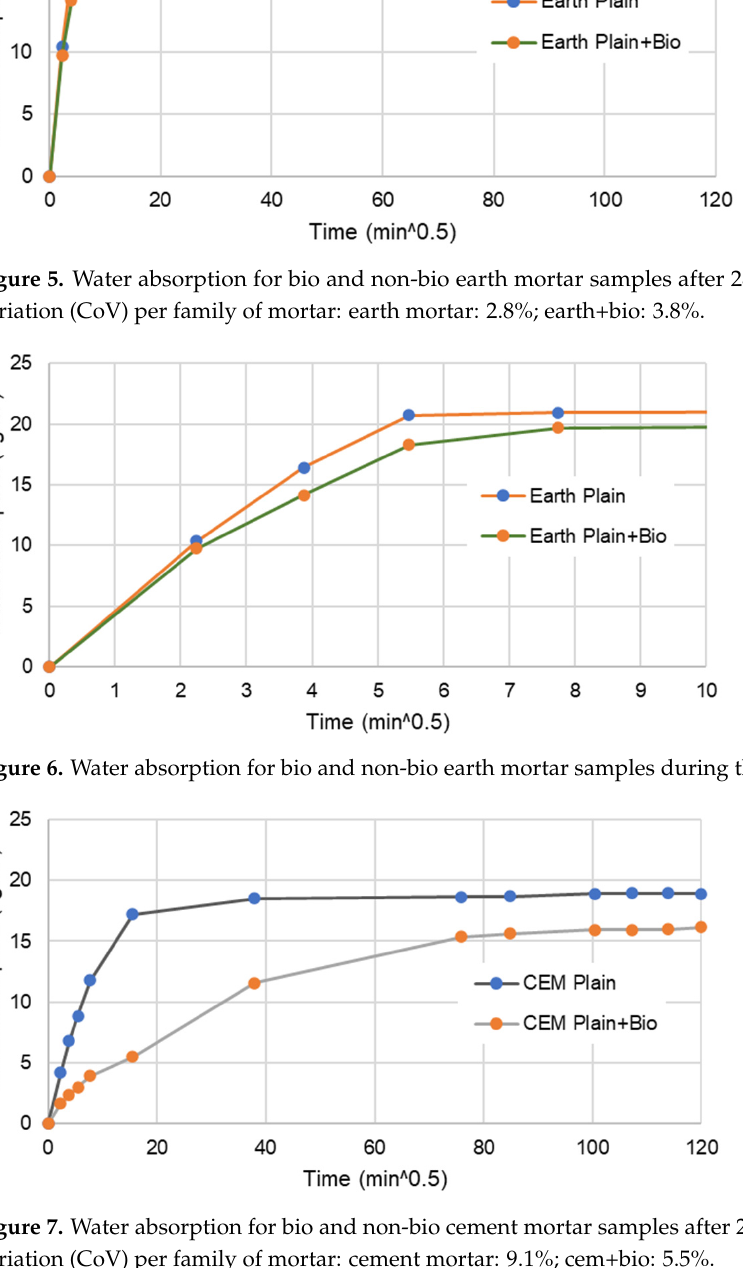
Figure 7. Water absorption for bio and non-bio cement mortar samples after 28 days. Coefficient of variation (CoV) per family of mortar: cement mortar: 9.1%; cem+bio: 5.5%.